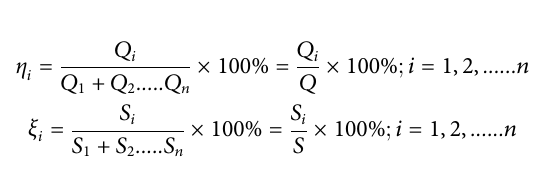
Frontiers in Earth Science |